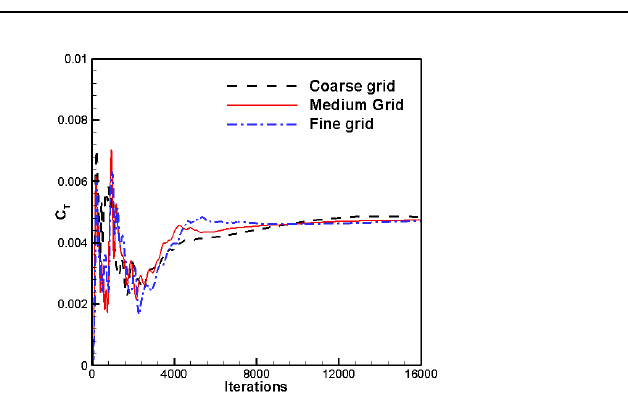
Energies 2019 , 12 , x FOR PEER REVIEW